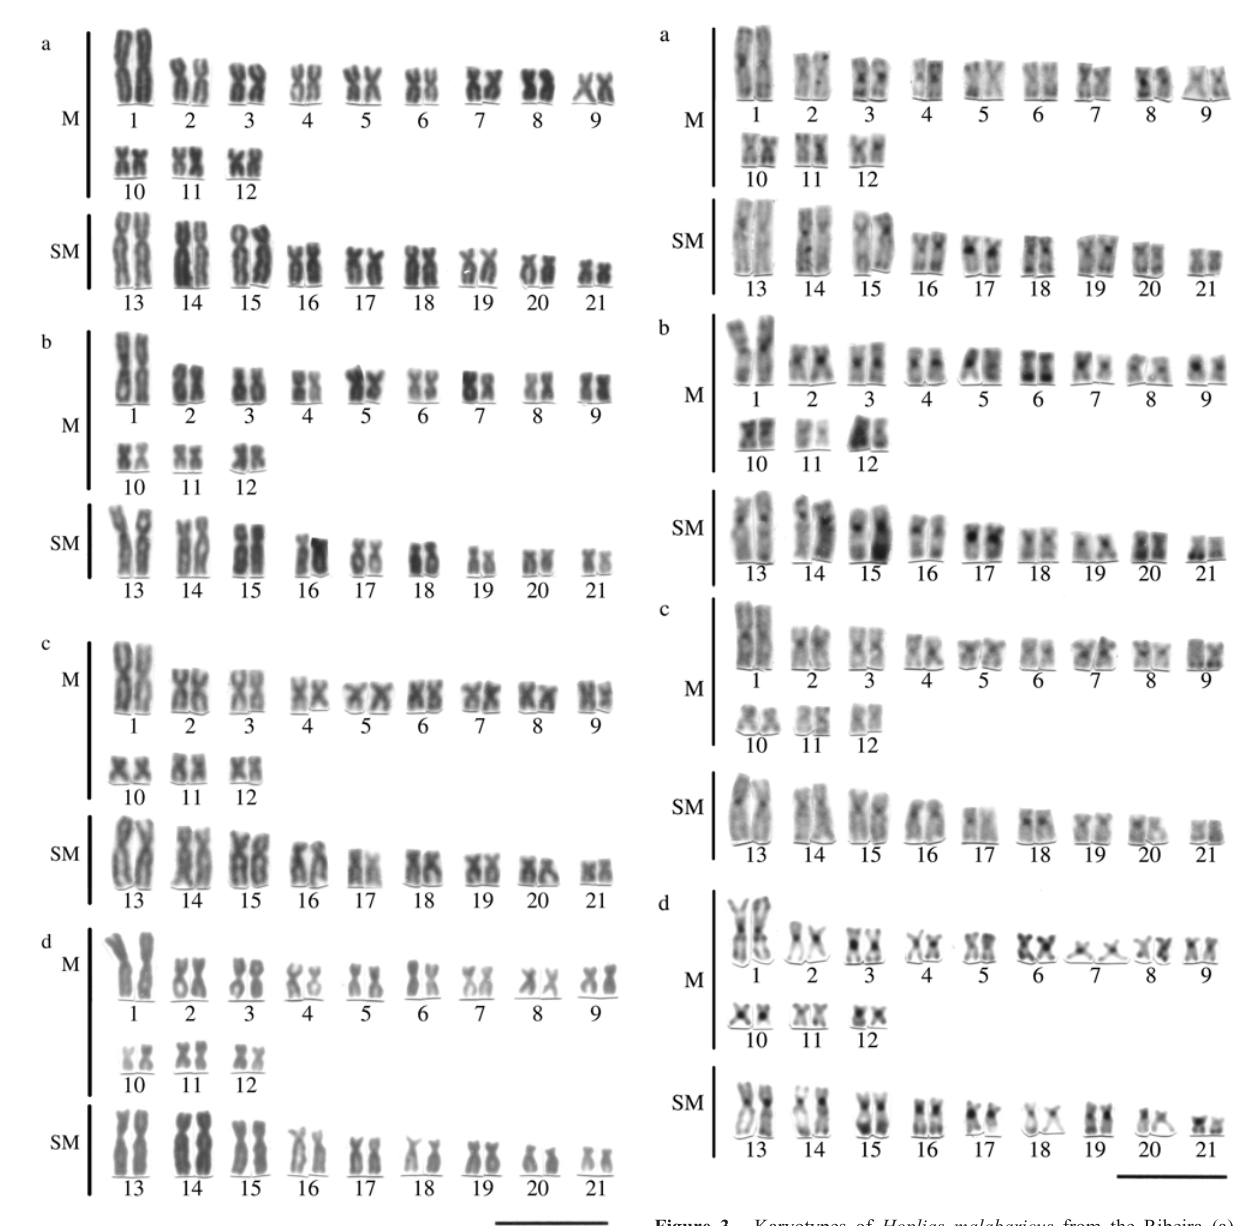
Figure 3 - Karyotypes of Hoplias malabaricus from the Ribeira (a), Tibagi (b), Ivaí (c), and Iguaçu (d) populations (C-banding). Bar equals 5 µ